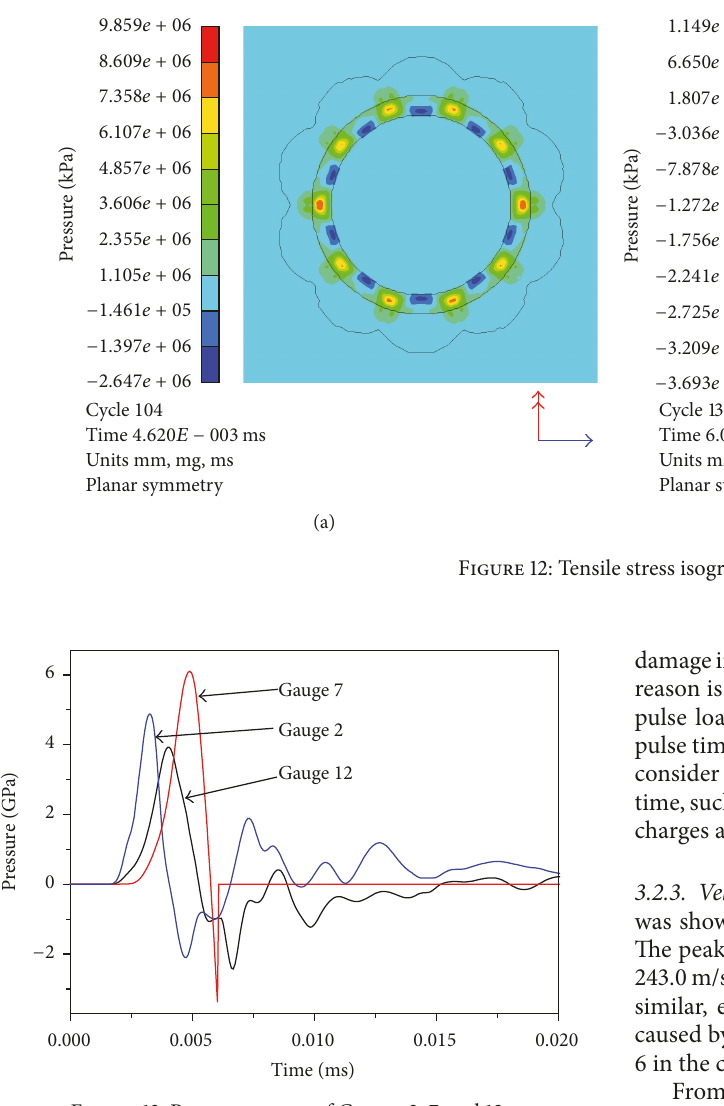
Figure 13: Pressure curves of Gauges 2, 7, and